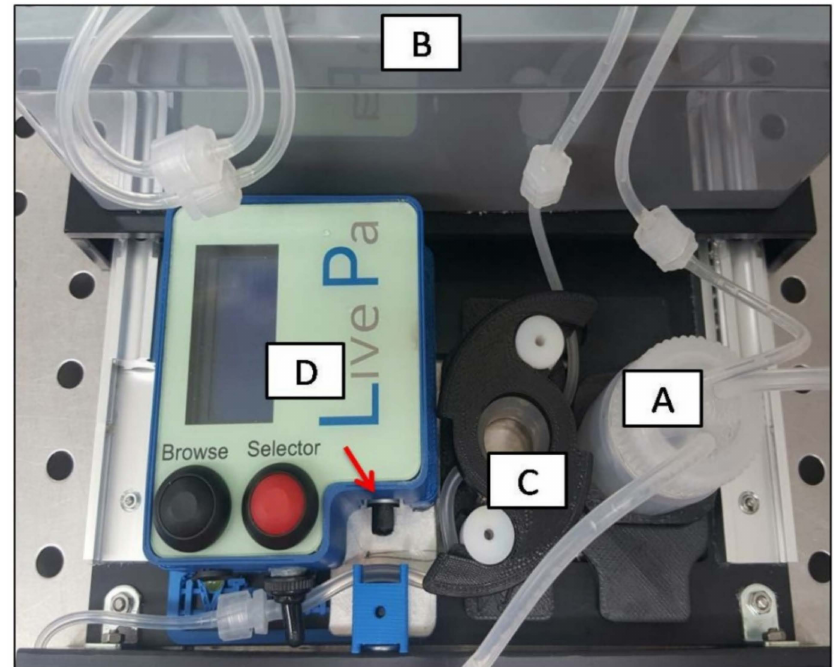
Figure 5. Perfusion bioreactor circuit diagram with the addition of Live Pa to increase culture chamber pressure. From the mixing bottle( A ), the medium was pumped by the action of a peristaltic pump ( B ) through the perfusion chamber where cells had been seeded ( C ). The Live Pa ( D ) was designed to press the outlet tube of the perfusion chamber (red arrow) in order to increase the pressure within the perfusion chamber. Then, the medium returned to the mixing bottle, completing the circuit. (The figure has been kindly provided by